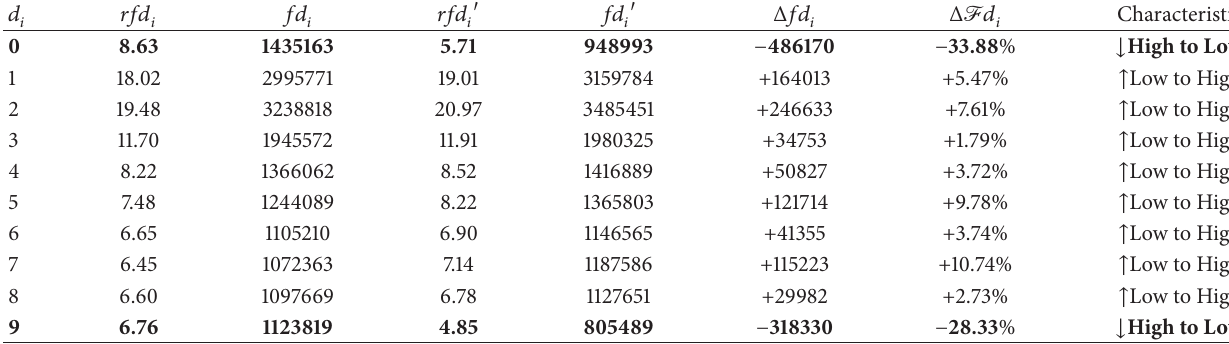
Table 8: Characterization of malicious update attacks on digit